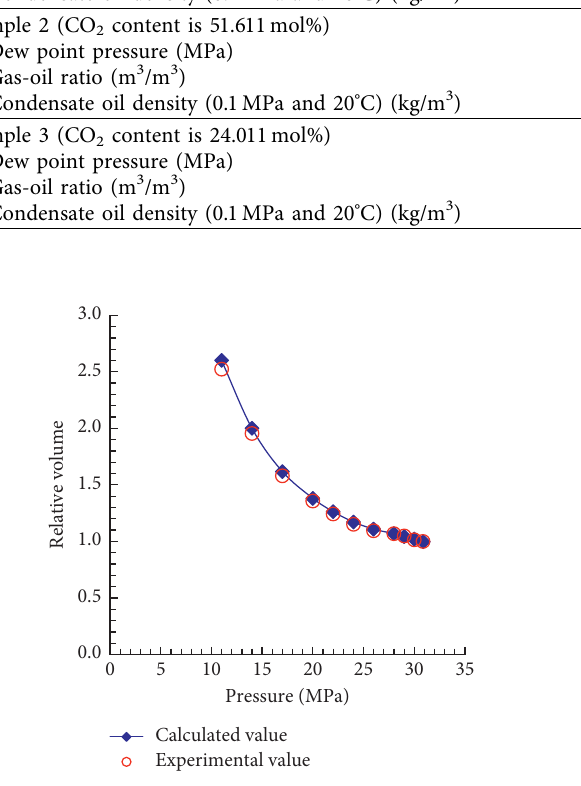
Figure 6: Comparison for sample 1 of calculated and experimental relationship diagram between relative volume and pressure.